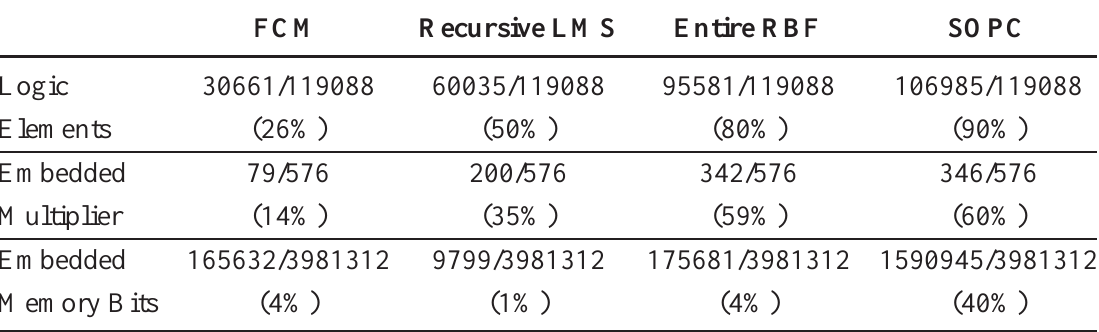
Table 8. The hardware resource consumption of the proposed architecture with n = 8 × 8 , c = 8 and q = 4